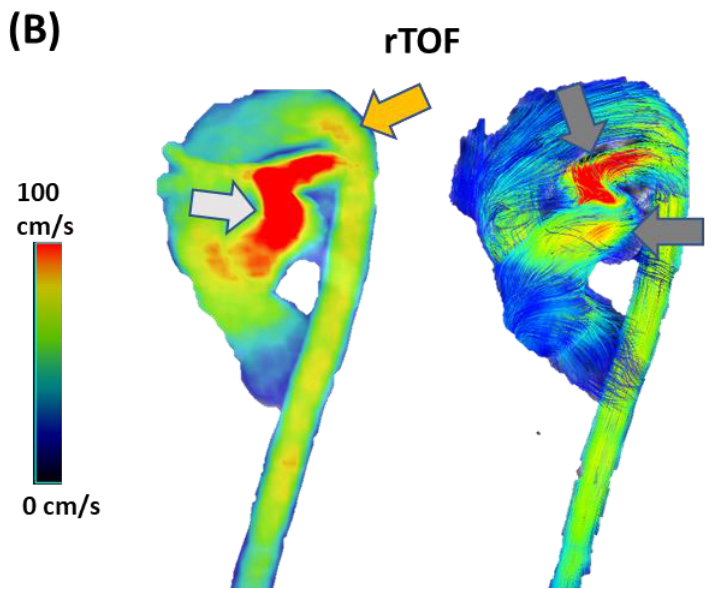
Figure 3. Comparison of velocity and flow patterns between a control and a patient with repaired Tetralogy of Fallow. Panel ( A ) shows homogeneous flow distribution in the velocity mapping (left) and laminar flow in the pulmonary artery and in the aorta (right). Panel ( B ) shows evidence of anatomic anomalies in the main pulmonary artery and aortic arch. These anomalies produced flow acceleration, as pointed by the light grey arrow in the pulmonary artery and the orange arrow in the aorta. Helical flow was also observed along the pulmonary artery, as pointed out by the dark grey arrows.